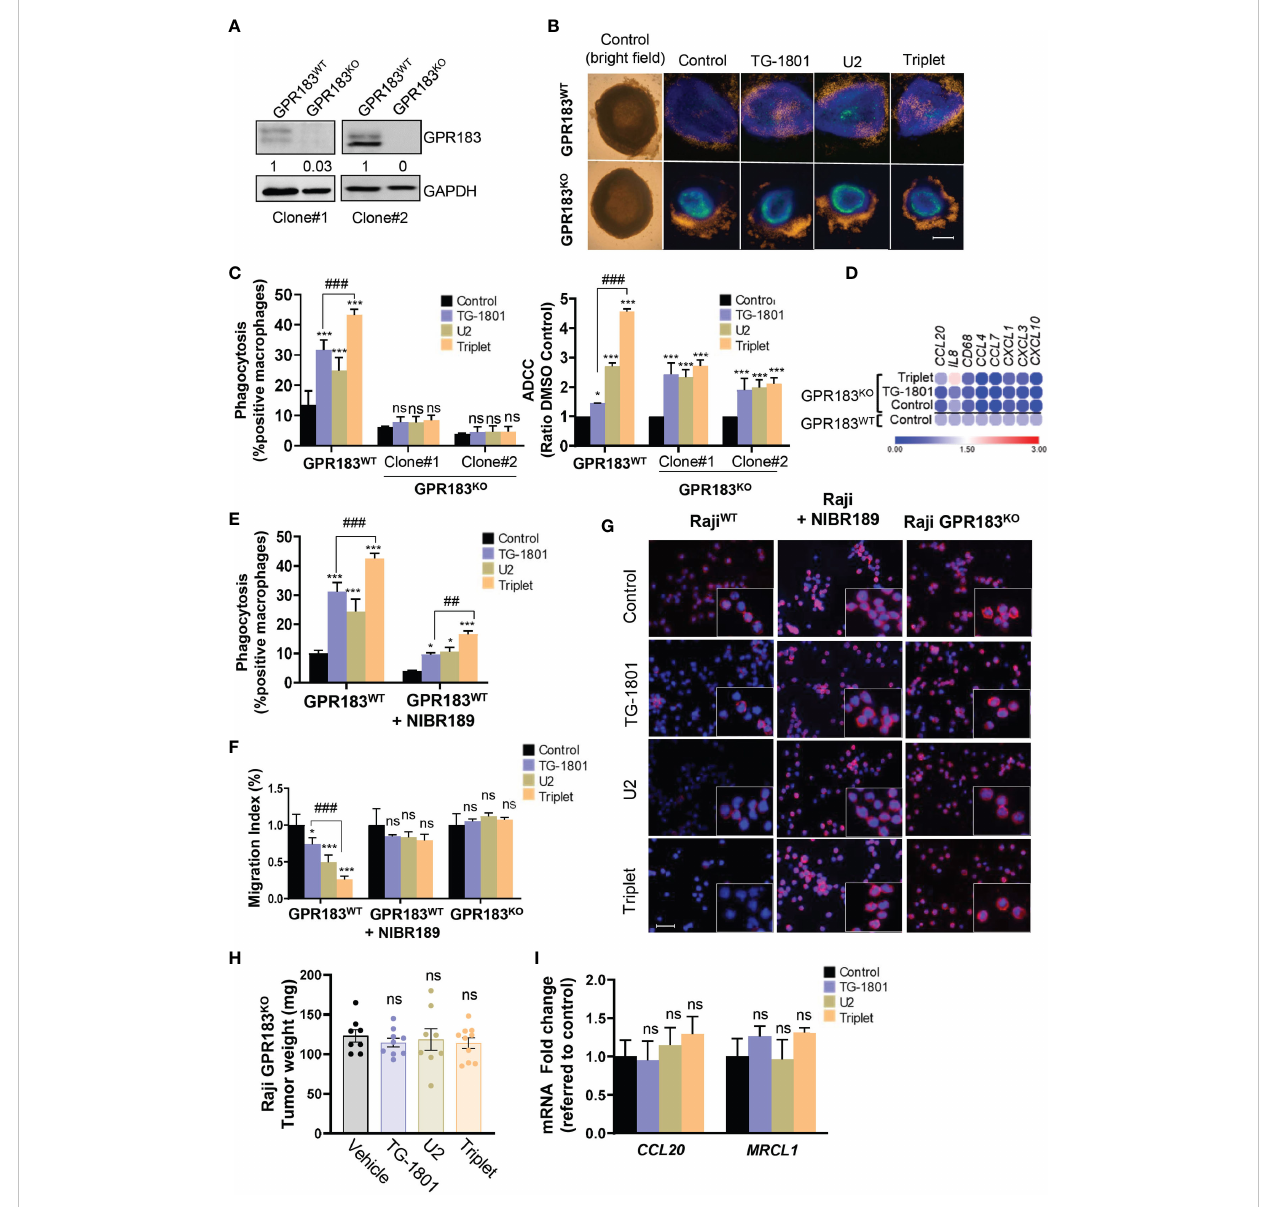
FIGURE 3 GPR183 is required for impaired B cell traf fi cking and tumour cell phagocytosis upon TG-1801/U2 triple combination therapy. (A) Immunoblot detection and densitometric quanti fi cation of GPR183 in both Raji-GPR183 WT and Raji-GPR183 KO cells, using GAPDH expression as a loading control. Values are referred to control, wild type cells. (B) Raji-GPR183 WT or Raji-GPR183 KO 3D spheroid in presence or absence of 10 ng/mL TG-1801 +/- U2 (10 µg/mL ublituximab + 1 µM umbralisib) for one more day. The in fi ltration of M1 macrophages was evaluated by live-cell red fl uorescence. Scale bar: 500 µm. (C) Triggering of phagocytosis (left panel) and cell-mediated cytotoxicity (right panel) was assessed in Raji-GPR183 WT and Raji- GPR183 KO cultures upon quanti fi cation of engulfed B cell red fl uorescence with pHrodo and LDH release assay, respectively. For each assay, shown are average values obtained from three independent replicates. (D) Raji-GPR183 WT and Raji-GPR183 KO were co-cultured with BMSCs, M2-polarized primary macrophages and PBMCs (4:1:1:1) and treated with vehicle, TG-1801 or the triplet combination for 24h. Then, puri fi ed CD20+ cells were subjected to RNA extraction and qPCR. Data are presented in fold-change related to the Raji-GPR183 WT control. (E) ADCP activities were assessed in Raji cells with or without the GPR183 inhibitor NIBR189 prior to treatment with 10 ng/mL TG-1801 +/- U2. Shown are average values from n=3 replicates. (F) The cell migration index of Raji-GPR183 WT , Raji-GPR183 KO (clone #1) cells exposed to the GPR183 inhibitor NIBR189, in presence or absence of 10 ng/mL TG-1801 +/- U2 combination. Shown are average values from n=3 replicates. (G) F-actin levels were assessed in the different cultures exposed to TG-1801 +/- U2 as in (E) , followed by staining with a TRITC-labelled phalloidin and direct red fl uorescence recording. Nuclei were counterstained with DAPI (blue) (shown are representative pictures from 1 out of 3 fi elds). Scale bar: 50 µm. (H) Tumour weights at day 15 for Raji GPR183 KO (N=8-10) exposed to TG-1801, U2 or triplet combination. (I) CCL20 and MRCL1 transcript levels in GPR183 KO tumours. Data are presented in fold-change related to the control (shown are median values from 8-10 replicates) according to the different treatment regimens. Values are expressed as mean ± SD. * p <0.05, *** p <0.001, when compared to control group. ## p<0.01 and ### p <0.001 when compared to TG- 1801 alone. ns, non-signi fi